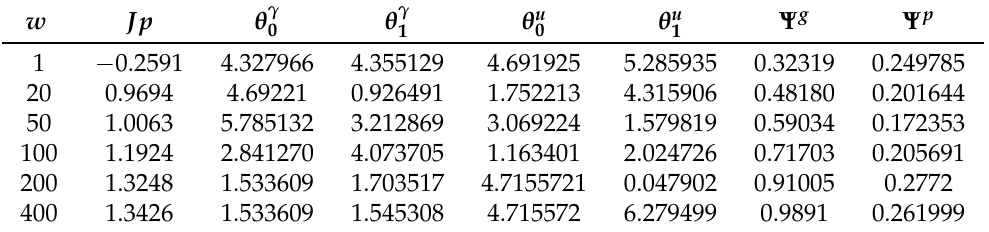
Table 5. Search evolution of HCQGA.